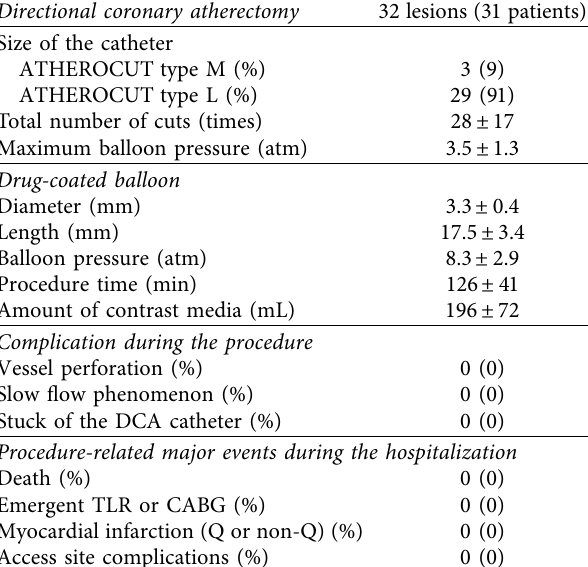
Table 2: Procedural